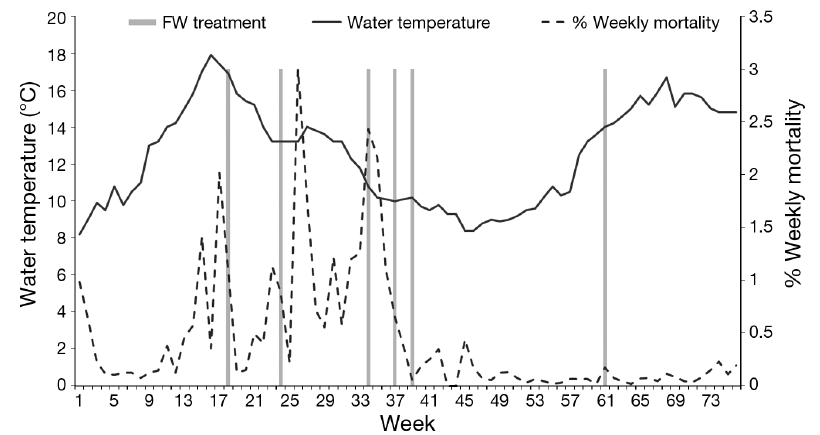
Fig. 3. Seawater temperatures, % weekly mortality rates of Atlantic salmon and the dates of freshwater bath treatments throughout the marine production